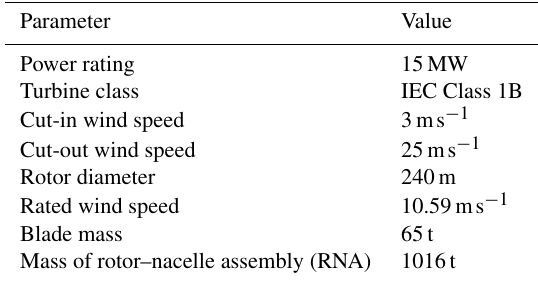
Table 1. IEA Wind 15MW reference turbine